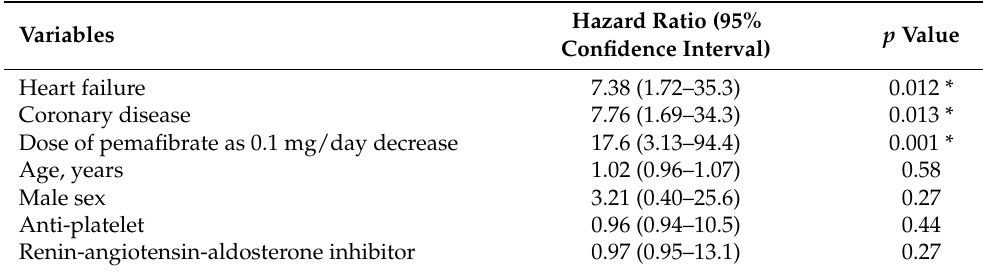
Table 3. The predictors for the composite primary endpoint among baseline